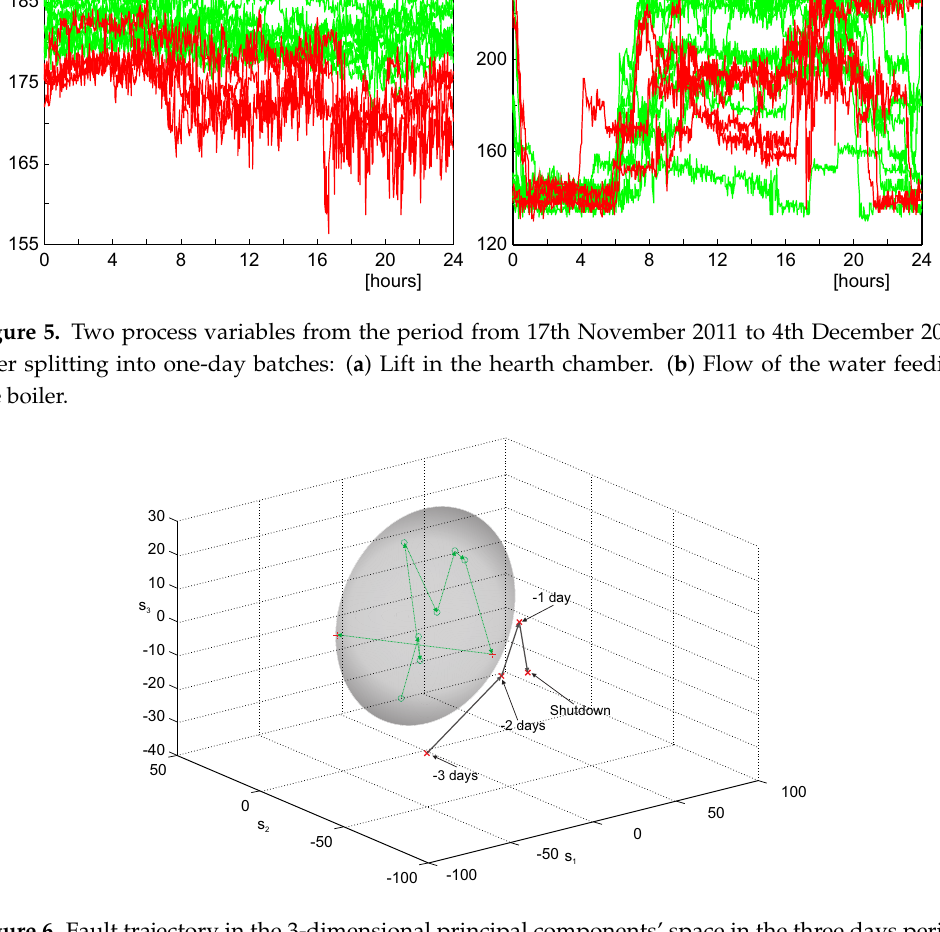
Figure 6. Fault trajectory in the 3-dimensional principal components’ space in the three days period before the shutdown—MPCA decomposition method (pipes damaged on 4th December